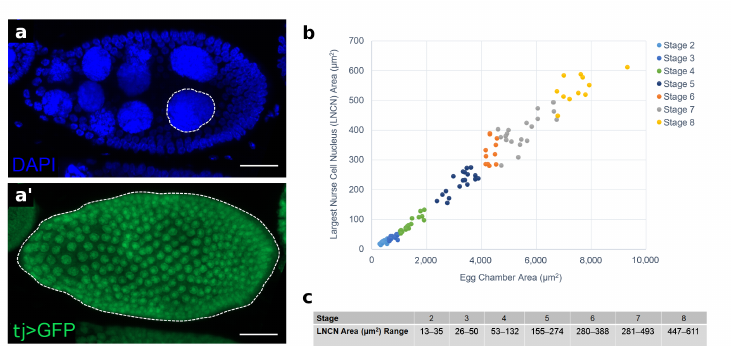
Figure A1. Egg chamber stage identification using the largest nurse cell nuclear area. ( a ) Confocal projection of a stage 8 egg chamber centered on the largest nurse cell nucleus (LNCN) marked with blue (DAPI). The dotted white line illustrates how area measurements were taken at the widest point of the LNCN of a projection. ( a’ ) Confocal projection of te entire egg chamber with follicle-cell-specific expression of GFP driven by tj-Gal4 (green). Dotted line illustrates how measurements were taken of egg chamber area at the widest point of the projection. ( b ) Standard curve of egg chambers from stages 2–8. There is a positive, linear relationship between egg chamber area and LNCN area. For stages 2–5 and 7, n = 20. For stages 6 and 8, n = 11. ( c ) Table of LNCN area ranges for each stage. Scale bar = 20 µ m.